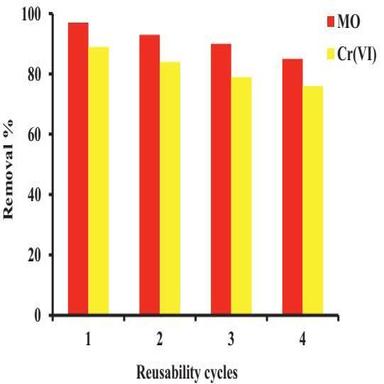
Reusability of Mus/St/MNPs composite for four adsorption-desorption cycles in the removal of Cr(VI) and MO.